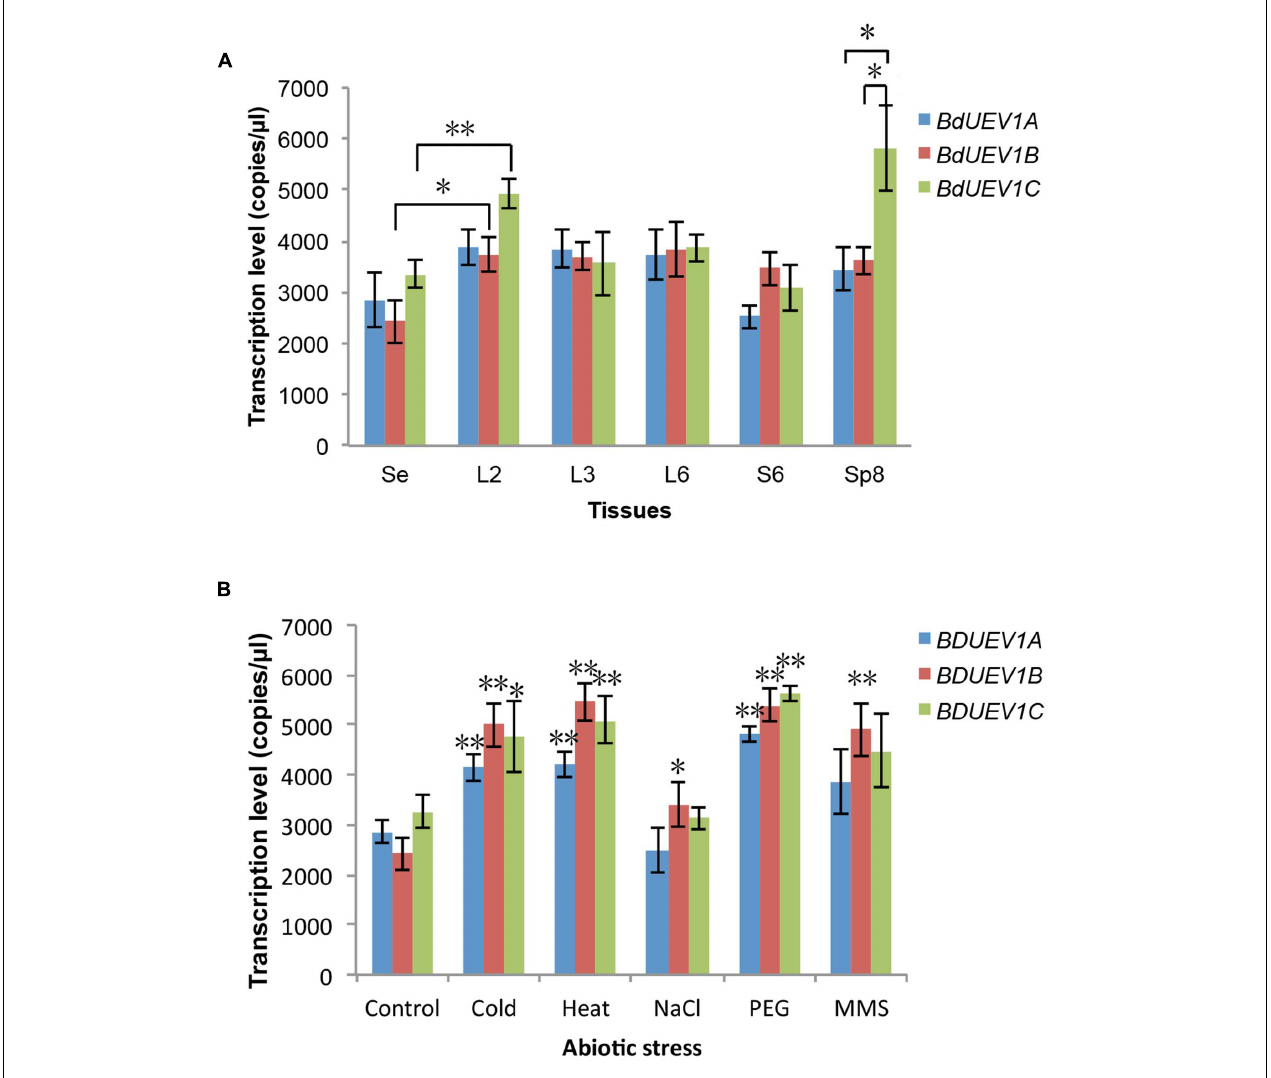
FIGURE 8 | Quantitative analysis of expression of BdUEV1 s. (A) Expression levels of BdUEV1 s in different tissues during B. distachyon development. Samples were taken from different developmental stages and tissues as indicated. Se: 7-day seedling; L2: leaves from 2-week old plants; L3: leaves from 3-week old plants; L6 and S6: leaves and stems from 6-week old plants; Sp8: spikes from 8-week old plants. (B) The expression of BdUEV1 s under different abiotic stresses. Control: 7-day old seedlings; Cold: 7-day old seedlings were treated at 4 ◦ C for 12 h; Heat: 7-day old seedlings were treated at 42 ◦ C for 12 h; PEG: 7-day old seedlings were treated with 25% PEG for 12 h; MMS: 7-day old seedlings were treated with 0.01% MMS for 12 h. ∗ P < 0.05; ∗∗ P <